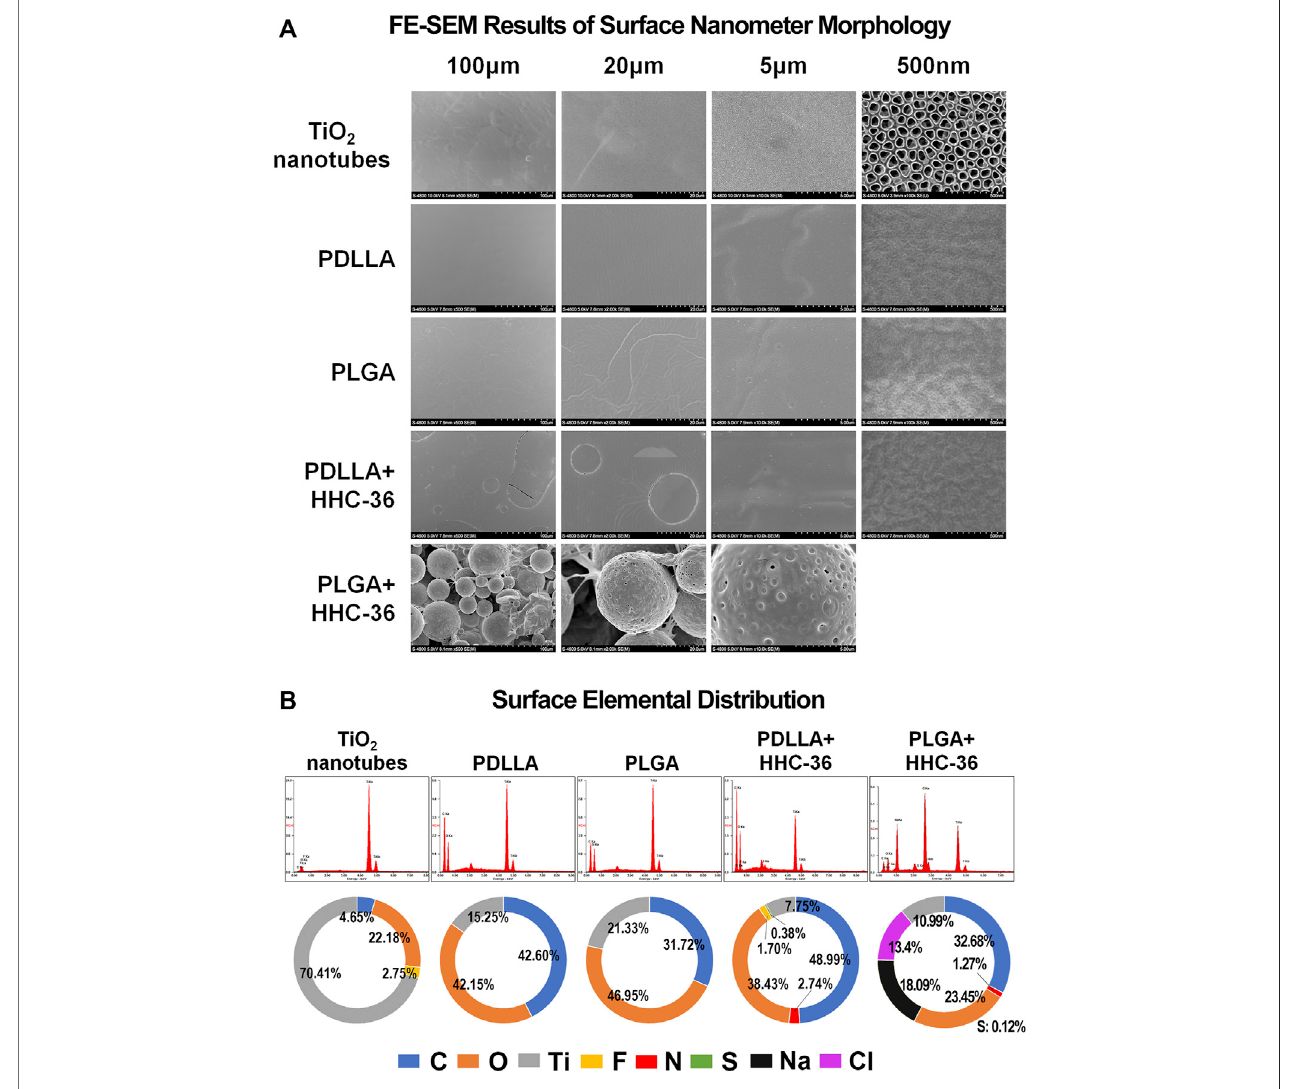
FIGURE 1 | Morphology and surface elemental distribution of the PDLLA/PLGA-HHC-36 coated titanium nanotube. ( A ) Field emission scanning electron microscopy results of surface nanometer morphology. ( B ) Surface elemental distribution of un-coated titanium nanotube group (control group), PDLLA/PLGA group, and PDLLA/PLGA-HHC-36